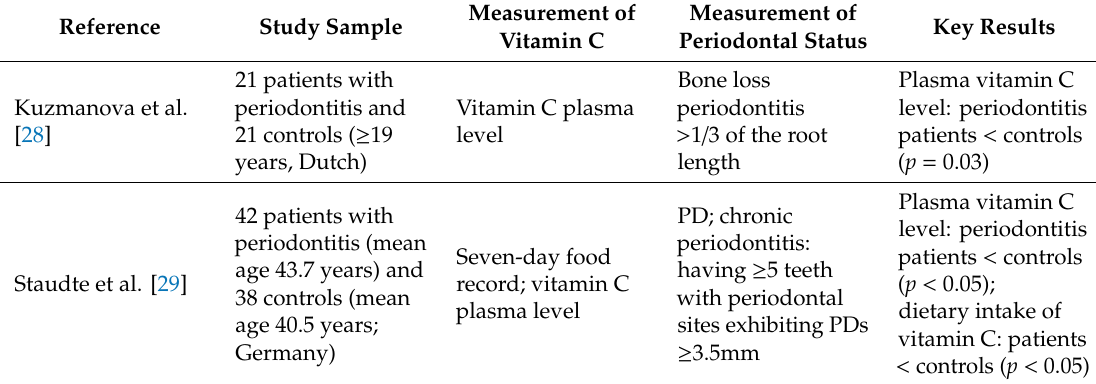
Table 7. Summary of the case-control studies on the relationship between of vitamin C and periodontal disease.